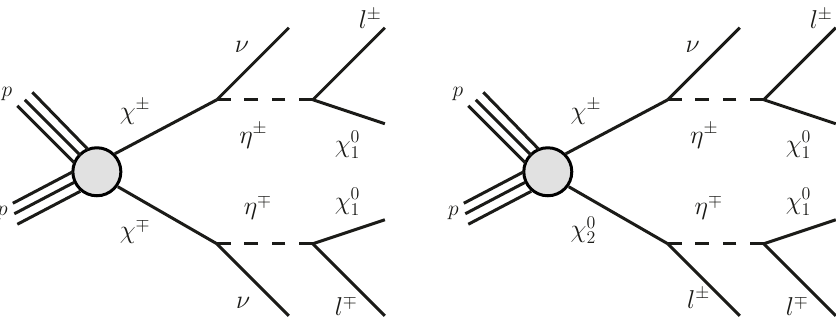
Figure 8 . Diagrams for two and three leptons plus missing energy that resemble SUSY